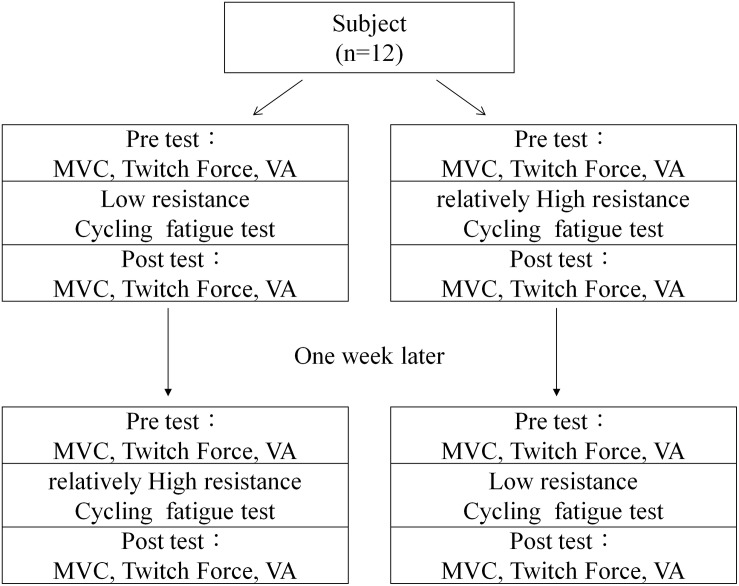
Flowchart of testing procedures.